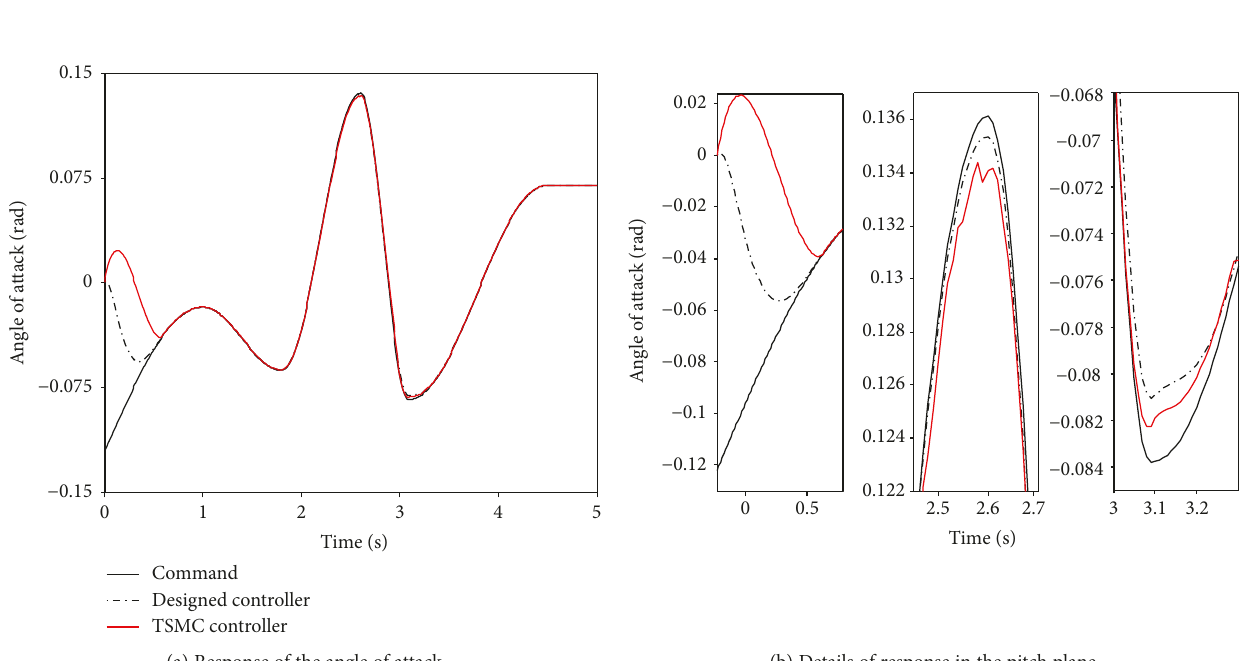
Figure 7: Time history of the angle of